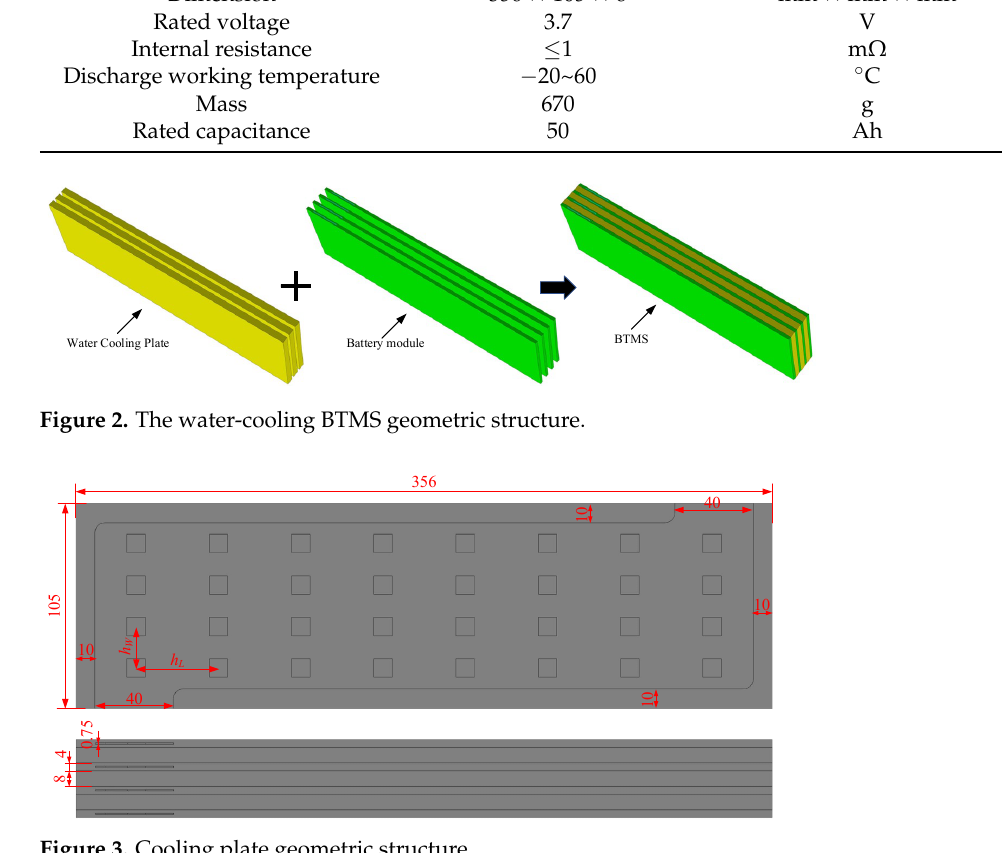
Figure 3. Cooling plate geometric structure.